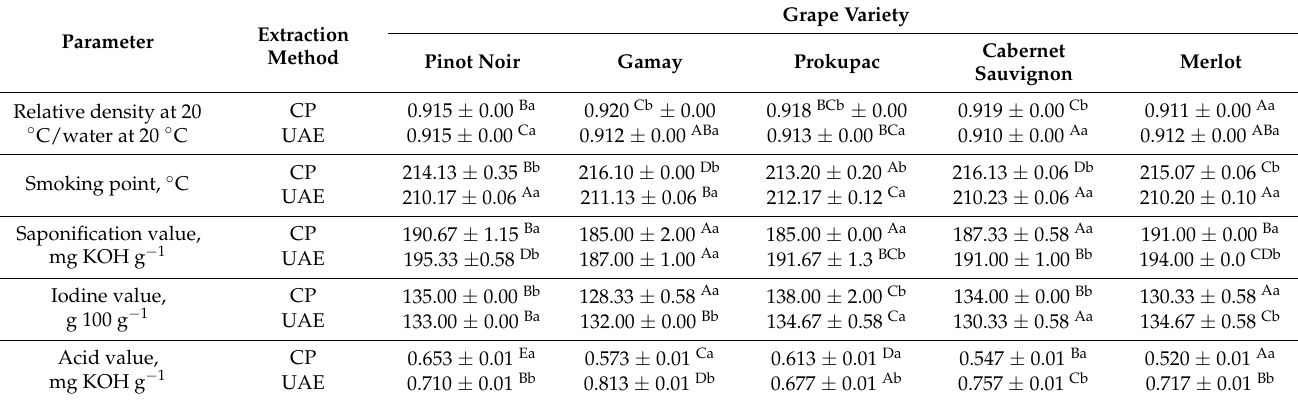
Table 1. Physicochemical parameters of the analyzed grape seed